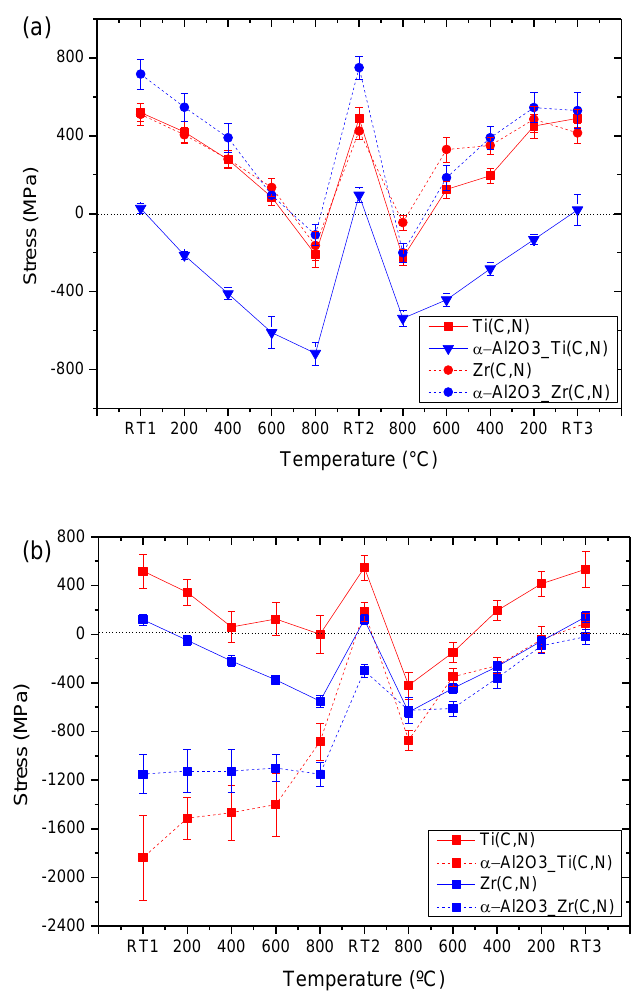
Figure 5. In situ determined stresses for the Zr(C,N)/ α -Al 2 O 3 and the Ti(C,N)/ α -Al 2 O 3 systems for the as-coated ( a ) and top-blasted ( b ) conditions.